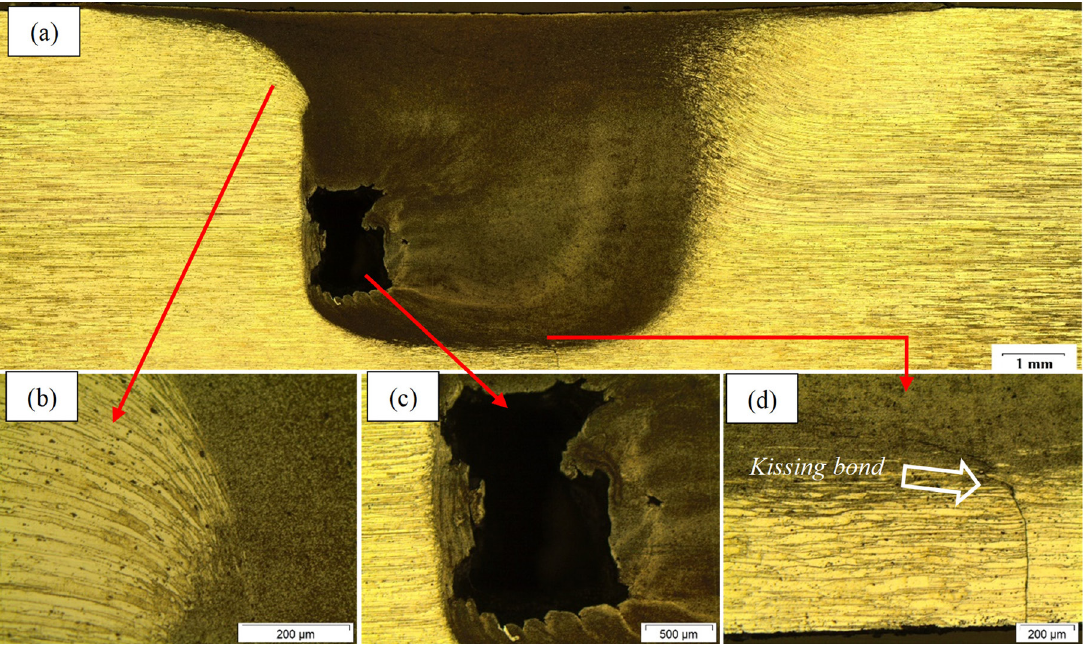
Figure 8. Macro and microstructure of the welded joint 3: (a) Macrograph of the cross section, (b) Micrograph of the region between TMAZ and SZ on the retreating side, (c) welding defect in the SZ on the retreating side, and (d) kissing bond welding defect.